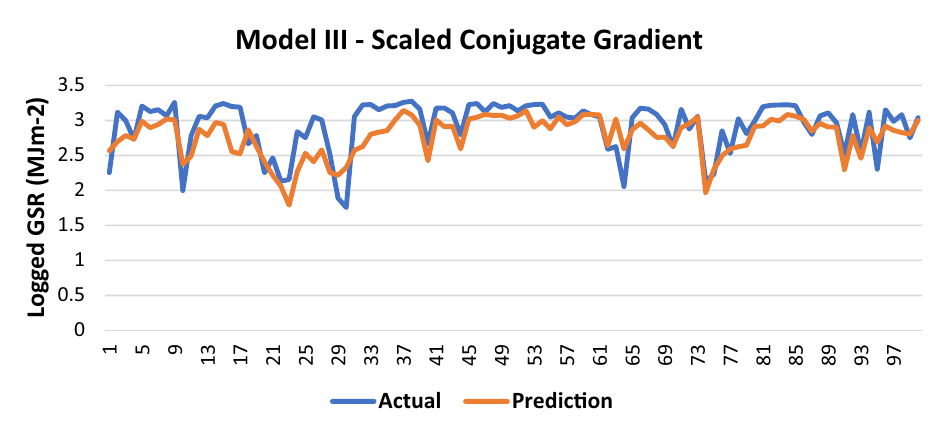
Figure 10. Graph of Actual and Predicted GSR (Model III—SCG).